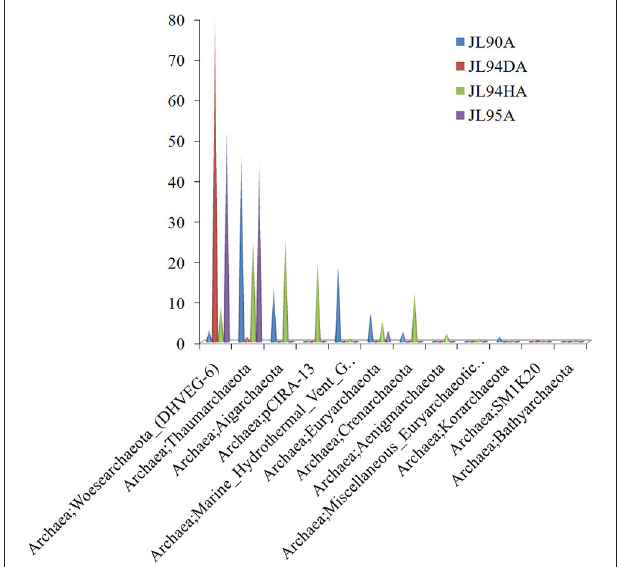
FIGURE 2 | Taxonomic relative abundance of archaeal classes observed of chimney samples for Longqi vent field at SWIR. Bar charts show the Kingdom; Phylum distribution for taxonomically assigned tags that occurred more than 1,000 times.